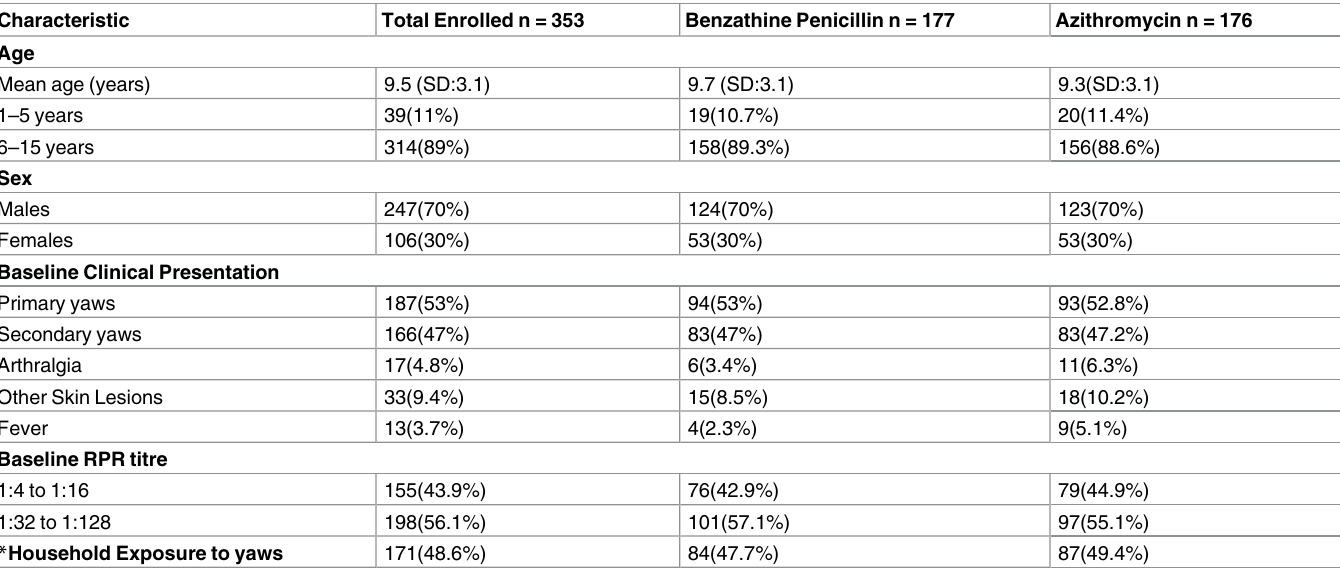
Table 1. Baseline Characteristics of Intention- to- Treat